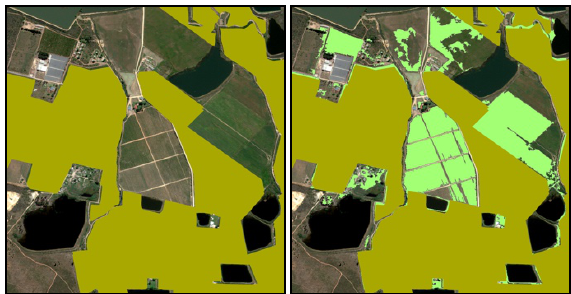
Figure 9. Left: Topographic data (2010), Right: Topographic data with changes (light green) WorldView-2 Image Copyright 2014, DigitalGlobe